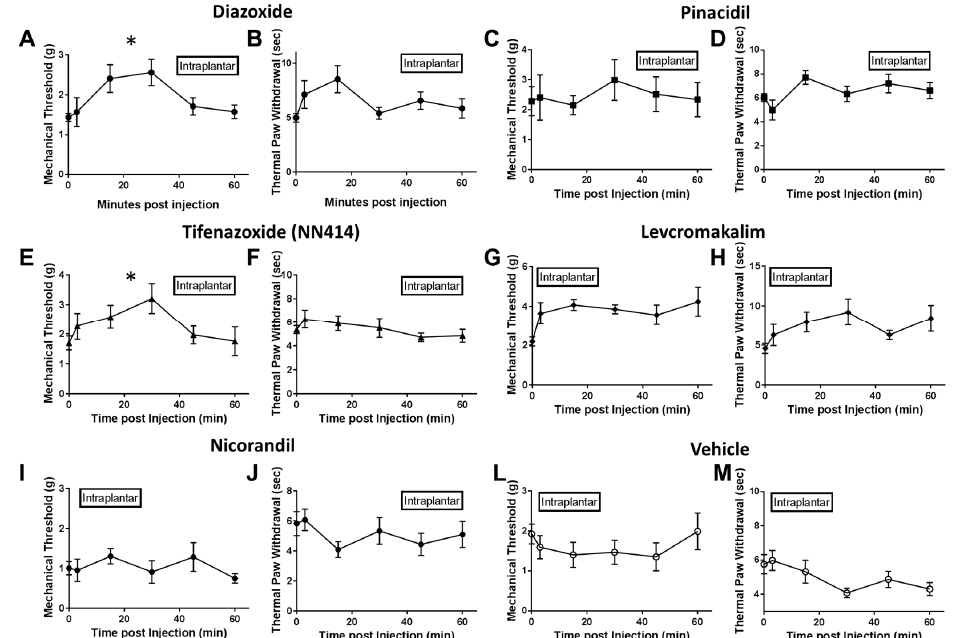
Figure 4. Paw withdrawal thresholds and latencies are increased after intraplantar administration of SUR1 agonists. Administration of the SUR1 agonist diazoxide ( A ) and the Kir6.2/SUR1 agonist NN-414 ( E ) significantly increased mechanical paw withdrawal thresholds compared to vehicle ( L ) (10 μ L, hindpaw; repeated measures ANOVA, F (5, 44) = 9.719, * P < 0.05, repeated measures ANOVA, CI diazoxide = − 2.999 to − 0.9227, CI NN414 = − 1.167 to − 0.6546). Thermal latencies for diazoxide ( B ) and NN-414 ( F ) were not significantly different than vehicle ( M ). Mechanical and thermal thresholds for the SUR2 agonist pinacidil ( C , D ), the Kir6.2/SUR2 agonist levcromakalim ( G , H ) or the Kir6.2/SUR2B agonist nicorandil ( I , J ) were not significantly changed compared to vehicle ( L , M ). Error bars: SEM; n = 5–12/group.